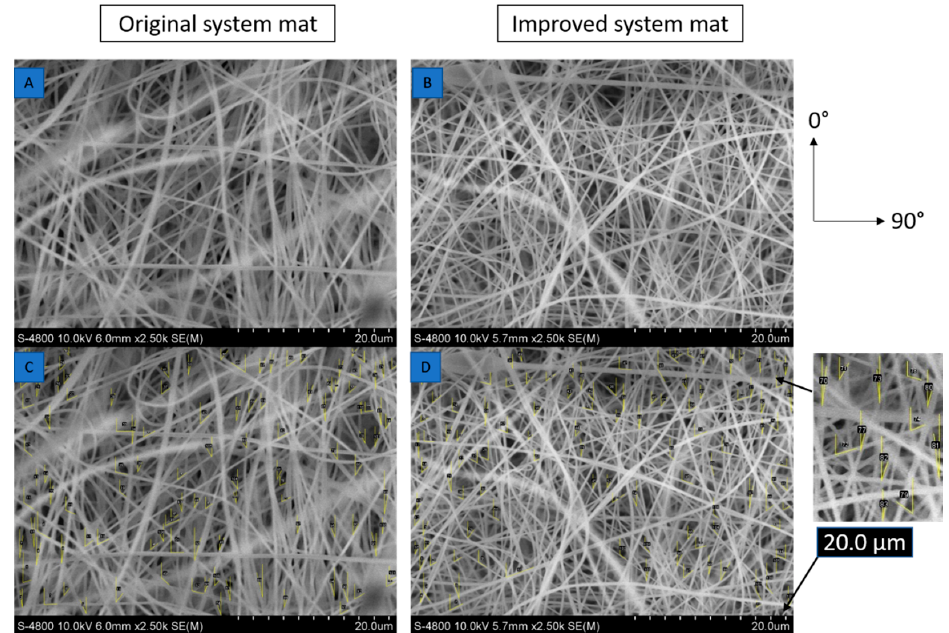
Figure 6. SEM images and angular measurements of mats from the ( A ) original and ( B ) improved systems. Orientations are measured using Image J software for ( C ) original and ( D ) improved systems. Additional data is available in the supplementary file.